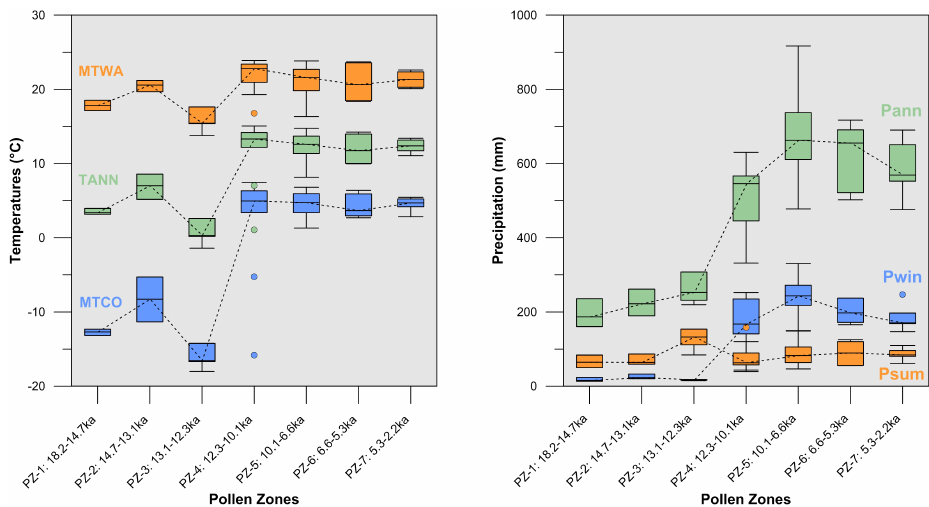
Fig. 5. Box-Whisker plots of estimated annual, summer and winter temperatures (TANN, MTWA, MTCO) and precipitation (Pann, Psum, Pwin) derived from the pollen data of core MD04-2797CQ (Peyron et al.,